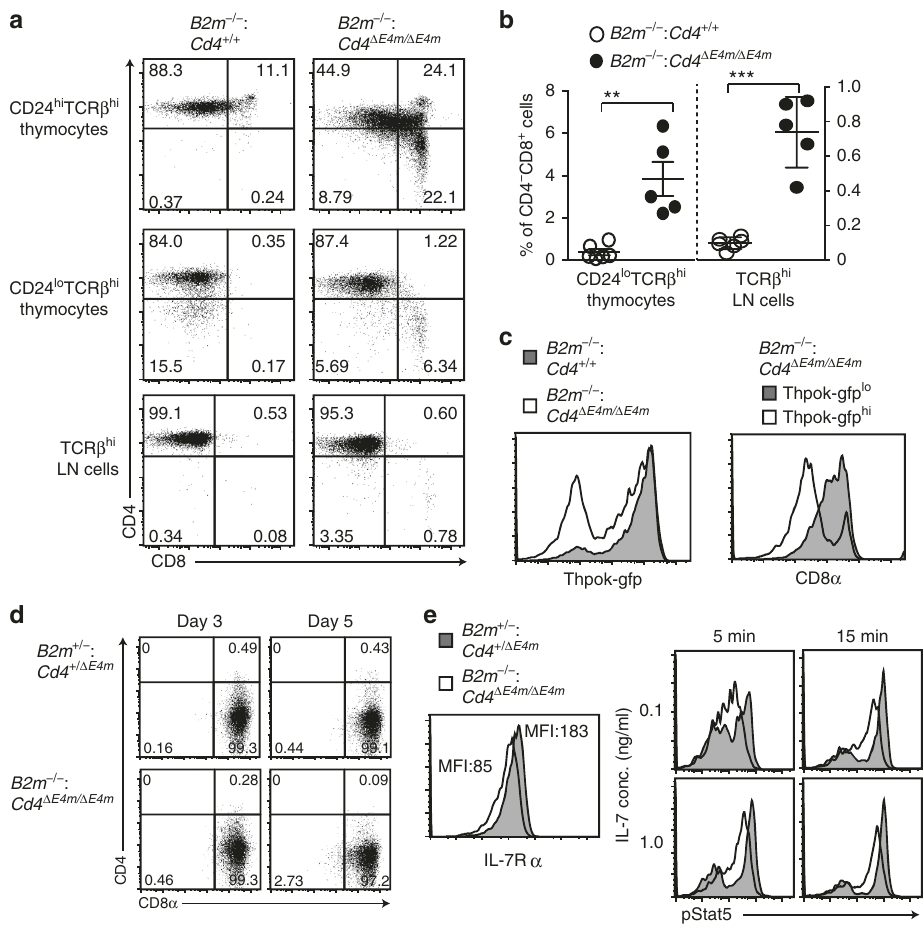
Fig. 3 Re-directed differentiation of MHC-II selected thymocyte by loss of the E4m enhancer. a , b Dot plots in a showing CD4 and CD8 expression in indicated cell subsets from B2m − / − : Cd4 + / + and B2m − / − : Cd4 Δ E4m/ Δ E4m mice. Graphs in b showing summary of percentage of CD4 − CD8 + cells in mature (CD24 lo TCR β hi ) thymocytes and the lymph node (LN) TCR β + population. Means ± SD. ** p < 0.01, *** p < 0.001 (unpaired student t test, two-sided). c Histogram at left showing Thpok-gfp expression in freshly-selected (CD24 hi TCR β hi ) thymocytes of B2m − / − : Cd4 + / + and B2m − / − : Cd4 Δ E4m/ Δ E4m mice. Histogram at right showing CD8 expression in Thpok-gfp lo and Thpok-gfp hi CD24 hi TCR β hi thymocytes of B2m − / − : Cd4 Δ E4m/ Δ E4m mice. One representative result of two mice. d Dot plots showing CD4 and CD8 expression three and fi ve days after TCR stimulation of sorted CD4 − CD8 + mature thymocytes from B2m + / − : Cd4 + / Δ E4m and B2m − / − : Cd4 Δ E4m/ Δ E4m mice. Numbers in quadrants indicate respective cell percentages. e IL7R expression in CD4 − CD8 + thymocytes (left) and phosphorylated Stat5 levels in CD4 − CD8 + thymocytes (right) at 5 and 15 min following IL7 stimulation at indicated concentrations from B2m + / − : Cd4 + / Δ E4m and B2m − / − : Cd4 Δ E4m/ Δ E4m mice are shown. Numbers in left histograms indicate mean fl uorescence intensity